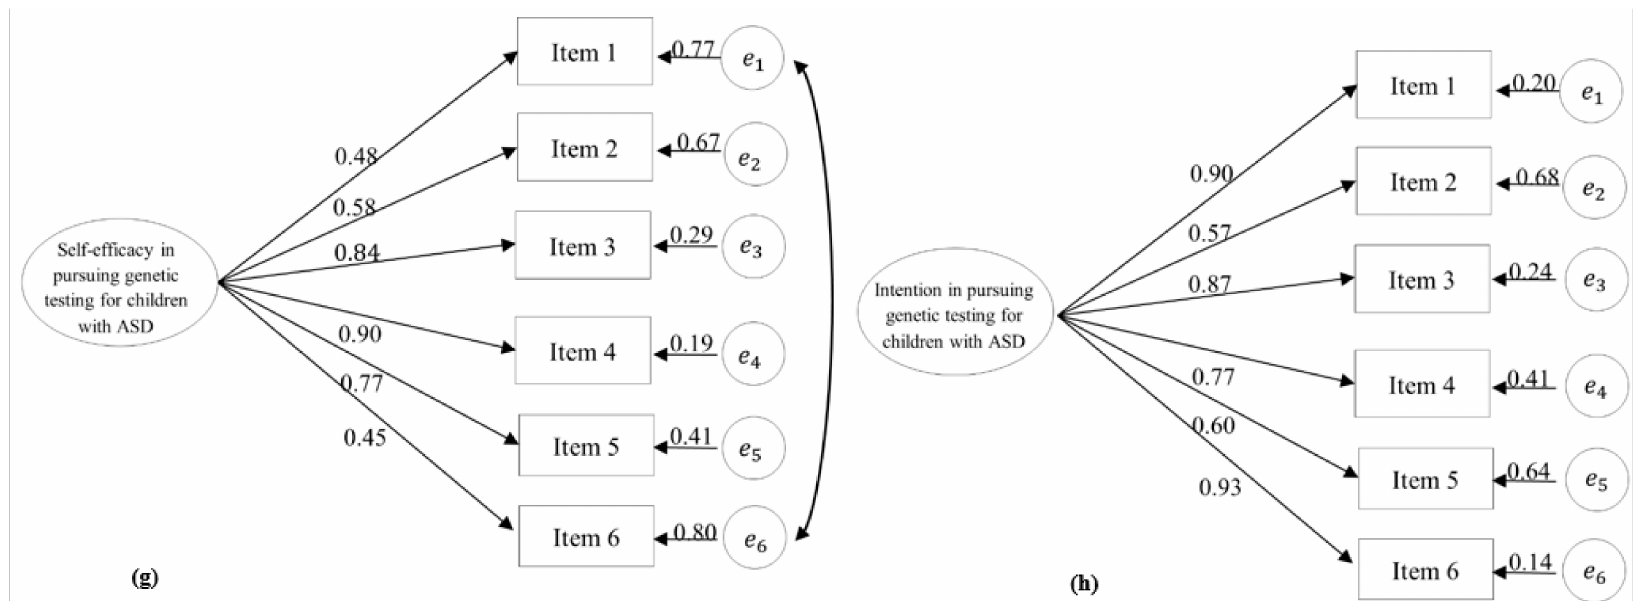
Figure 2. The confirmatory factor analysis (CFA) model for each scale of the POAGTS. ( a ) CFA model for Perceived Genetic Cause of ASD Scale; ( b ) CFA model for Perceived Severity of ASD Scale; ( c ) CFA model for Perceived Benefits of Genetic Testing for ASD Scale; ( d ) CFA model for Perceived Barriers in Pursuing Genetic Testing for Children with ASD Scale; ( e ) CFA model for Attitudes toward Genetic Testing for ASD Scale; ( f ) CFA model for Subjective Norms of Genetic Testing for ASD Scale; ( g ) CFA model for Self-efficacy in Pursuing Genetic Testing for Children with ASD Scale; ( h ) CFA model for Intention in Pursuing Genetic Testing for Children with ASD Scale. Note. The coefficients presented in each scale are standardized coefficients and all of them are statistically significant ( p <